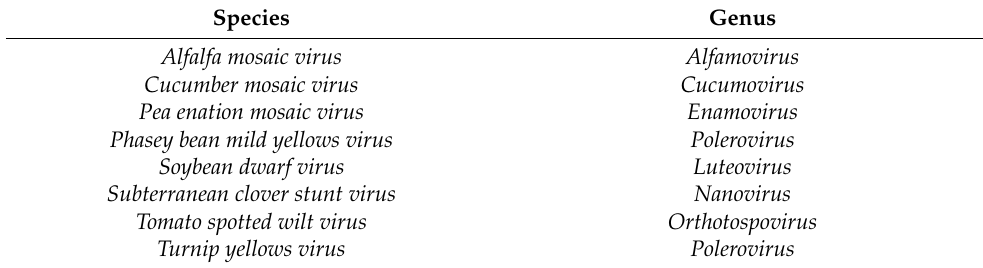
Table 1. List of viruses recorded in Tasmania infecting green peas [4]. Species Genus Alfalfa mosaic virus Alfamovirus Cucumber mosaic virus Cucumovirus Pea enation mosaic virus Enamovirus Phasey bean mild yellows virus Polerovirus Soybean dwarf virus Luteovirus Subterranean clover stunt virus Nanovirus Tomato spotted wilt virus Turnip yellows